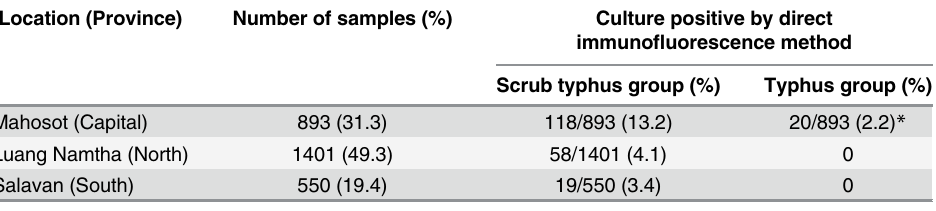
were confirmed by both IFA and PCR, of which 195 (90.7%) were scrub typhus and 20 (9.3%) were R . typhi (Table 2). The first 81 out of 195 (41.5%) O . tsutsugamushi isolates were selected for MLST; 74 (91.3%) were successfully amplified and sequenced, while the remaining 7 iso- lates produced poor quality data, most likely as a result of mixed infection. Of the final 74 iso- lates, 51 originated from Vientiane, 11 from Luang Namtha and 12 from Salavan. These 74 isolates corresponded to 50 different sequence types (STs), 43 of which were novel to this study (STs 50 through ST 92). Simpson ’ s index of diversity was calculated as 0.98 (95% CI 0.97 – 0.99) confirming a highly diverse population [24]. The seven STs that were not novel had been previ- ously reported by Sonthayanon et al. in a study of O . tsutsugamushi from patients presenting to Table 2. In vitro isolations from patients recruited in Laos during August 2008 to December